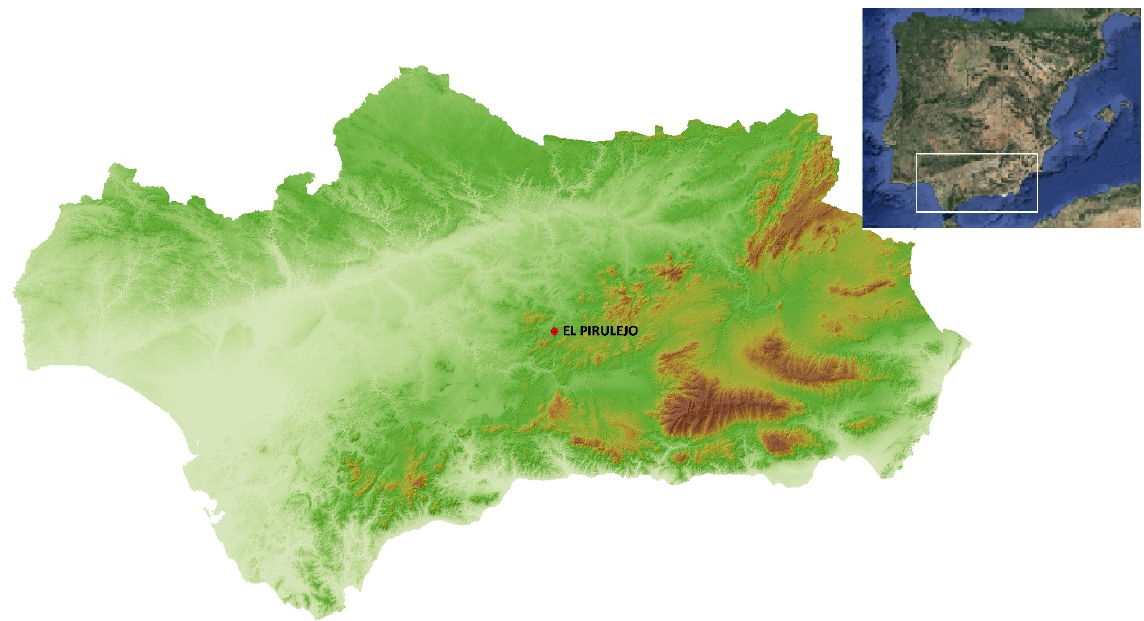
Figure 1. Location map of “El Pirulejo” site. (Compiled by